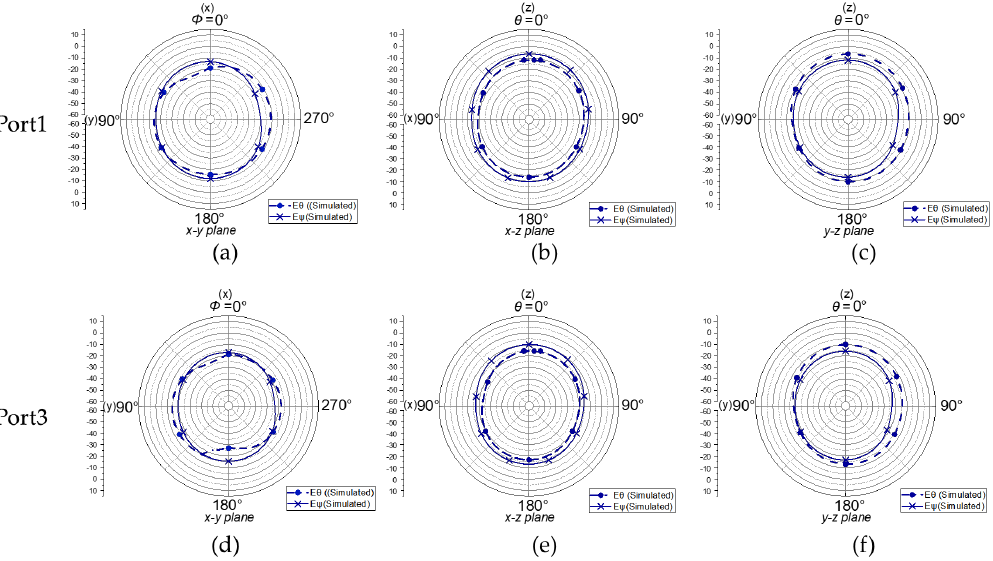
Figure 10. Antenna body with symmetrical square metal ring. (The parameters are: 𝐿 𝑎𝑛𝑡 = 760 μm,𝑊 𝑎𝑛𝑡 = 1145 μm,𝑊 1 = 25 μm,𝑊 2 = 250 μm,𝑊 3 = 575 μm,𝑊 4 = 55 μm,𝐿 1 = 210 μm,𝐿 2 =